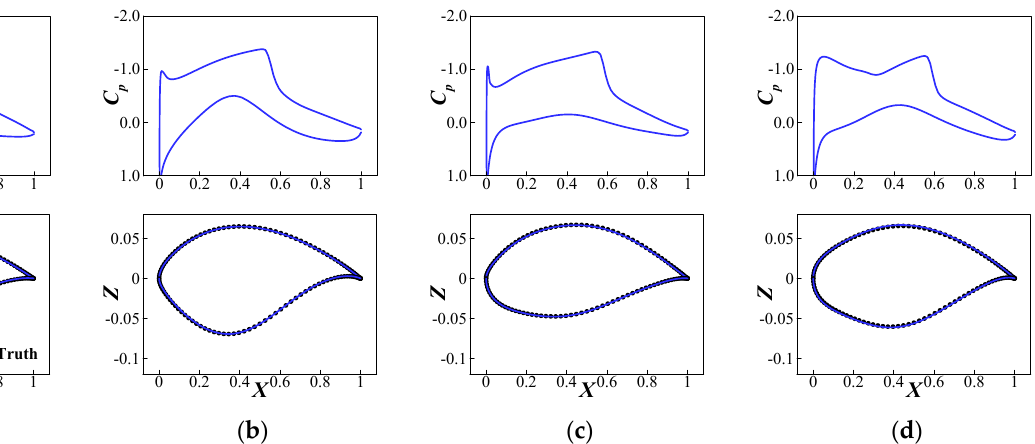
Figure 11. Typical predicted results by DCNN from different pressure distributions: ( a ) test sample 1; ( b ) test sample 2; ( c ) test sample 3; ( d ) test sample 4.